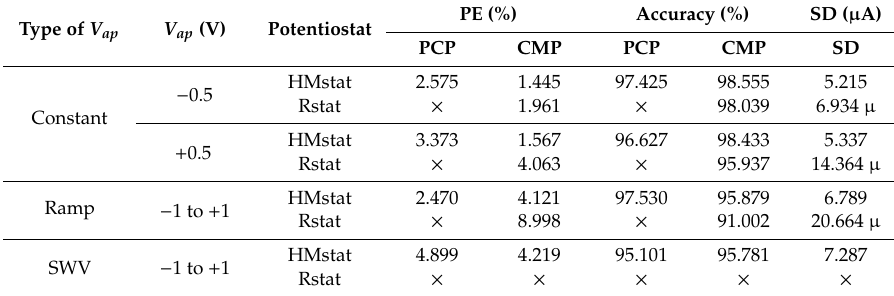
Table 3. Performance of HMstat and Rodeostat (Rstat) in term of percentage error (PE), accuracy, and noise current measurement (SD).